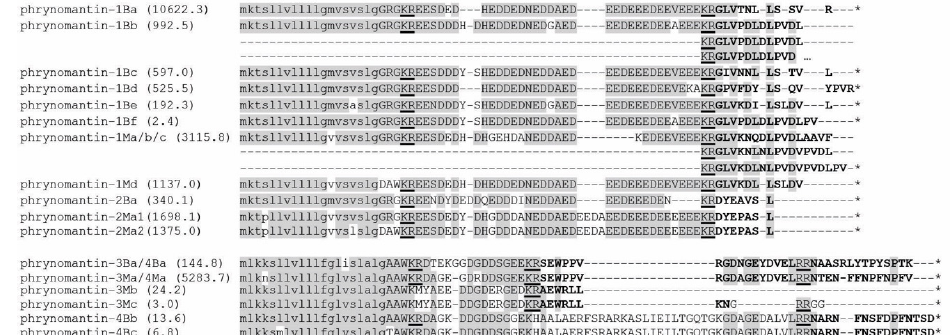
Figure 1. Sequence alignment of the 17 phrynomantin precursor proteins encoded by Phrynomantis skin transcripts. Predicted N -terminal signal peptides are printed in lower case, putative cleavage sites are underlined, predicted functional peptides (19 in total) are bold-faced. Conserved residues (identical in ≥ 50% of aligned sequences) are shaded in grey. Numbers behind sequences represent expression estimates (in transcripts per million; TPM).